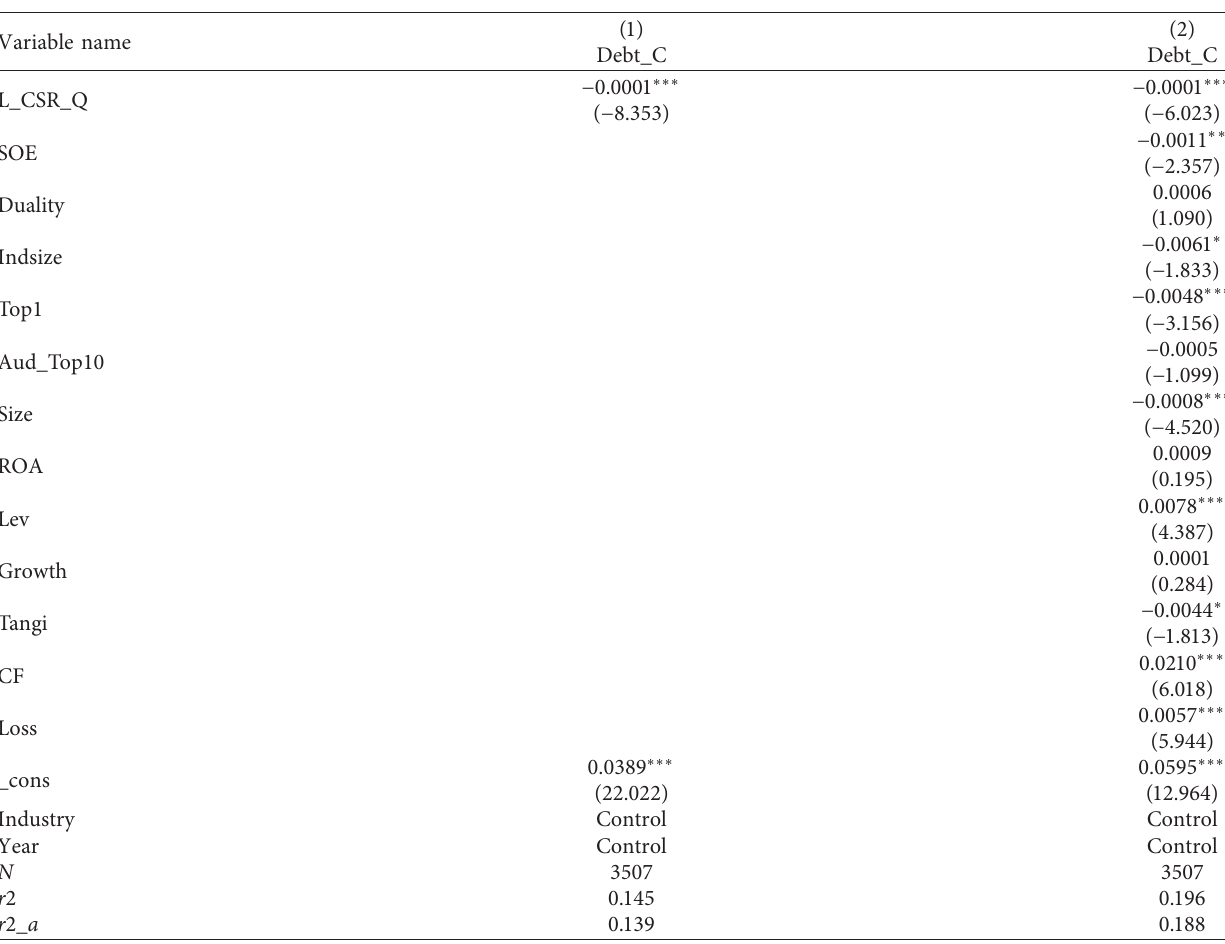
Table 11: Robustness test 4: lagging the explanatory variables by one period.